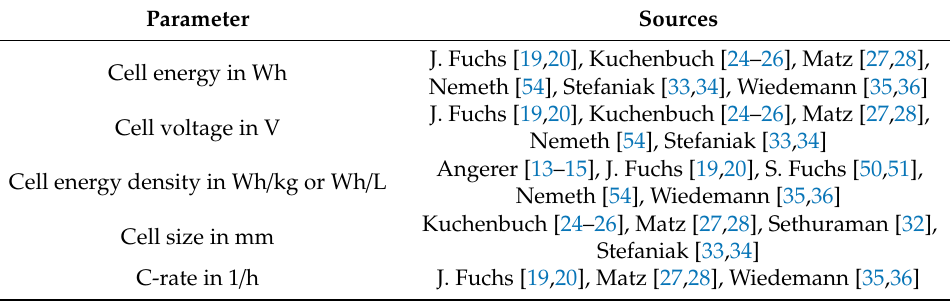
Table 4. Overview of the design parameters for the cell.